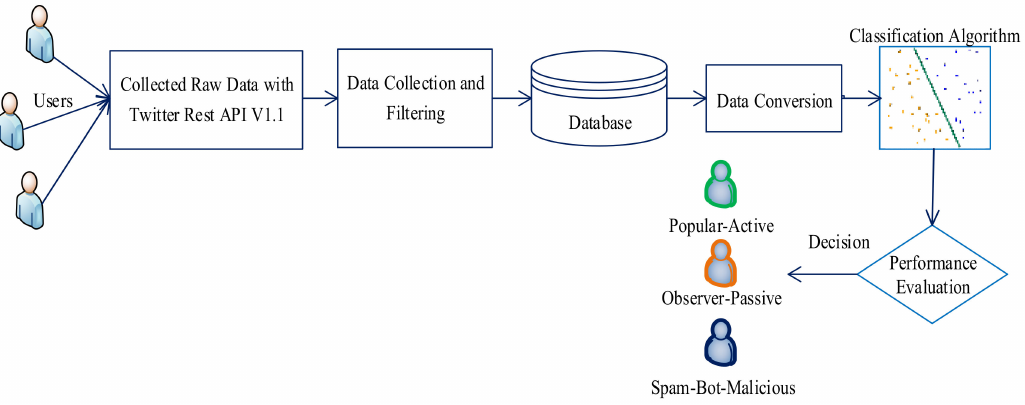
Figure 1. Flow diagram of the